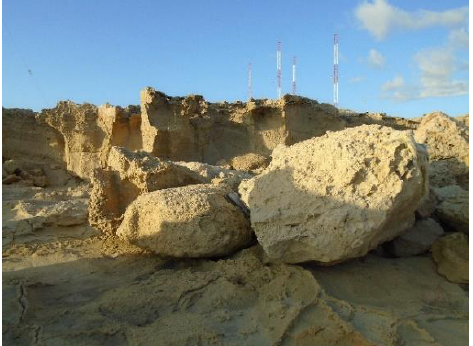
Figure 11. The boulders owe their dislocation to the collapse of the landward part of the rocky platform, which is visible in the back.